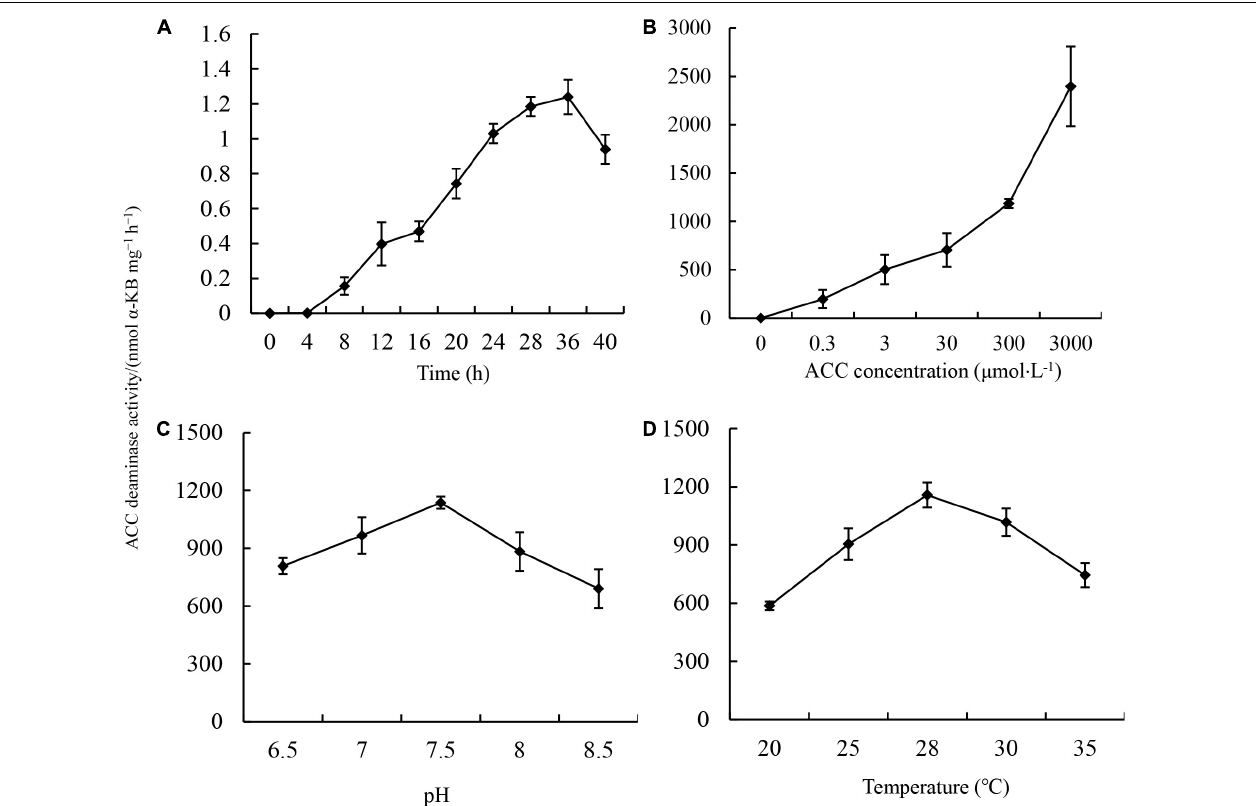
FIGURE 3 | Effects of inducing time (A) , ACC concentration (B) , pH (C) , and inducing temperature (D) on ACC deaminase activity in S. marcescens JW-CZ2. Data indicate mean and standard deviation ( n = 3). Different letters indicate significant differences ( p < 0.05).